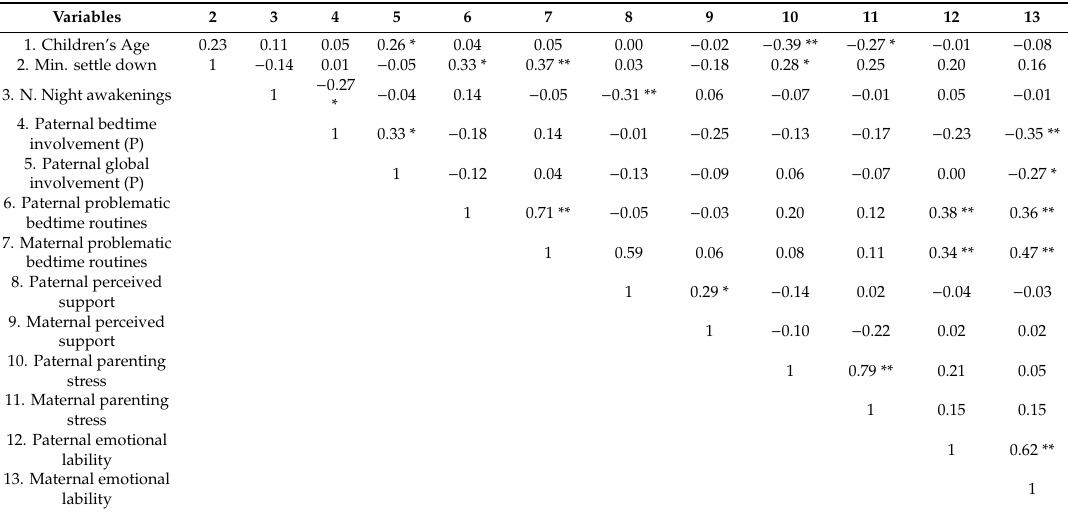
Table 1. Correlations among variables under